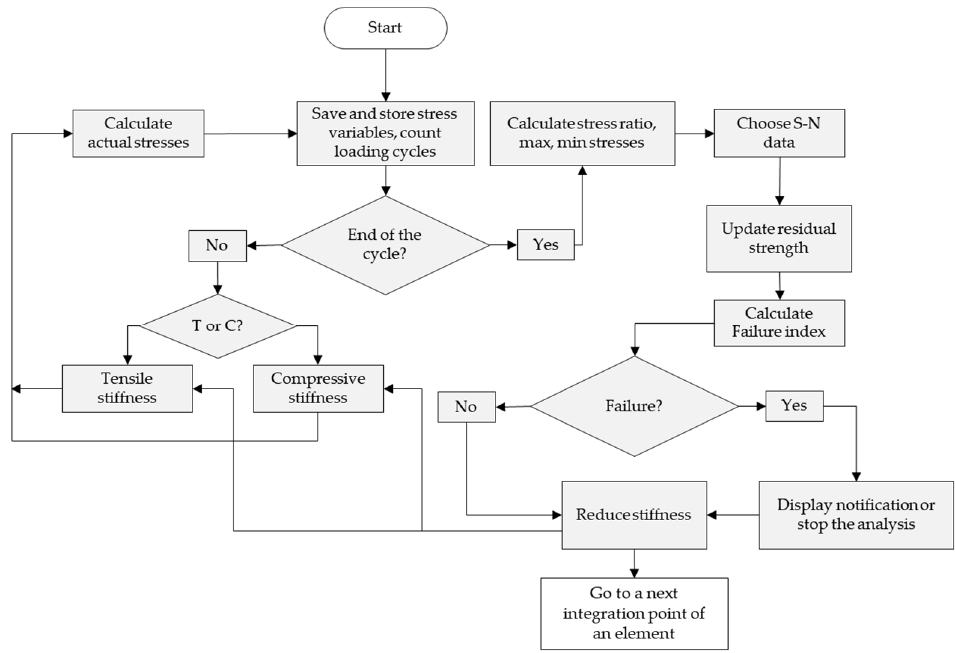
Figure 3. The FDM workflow.